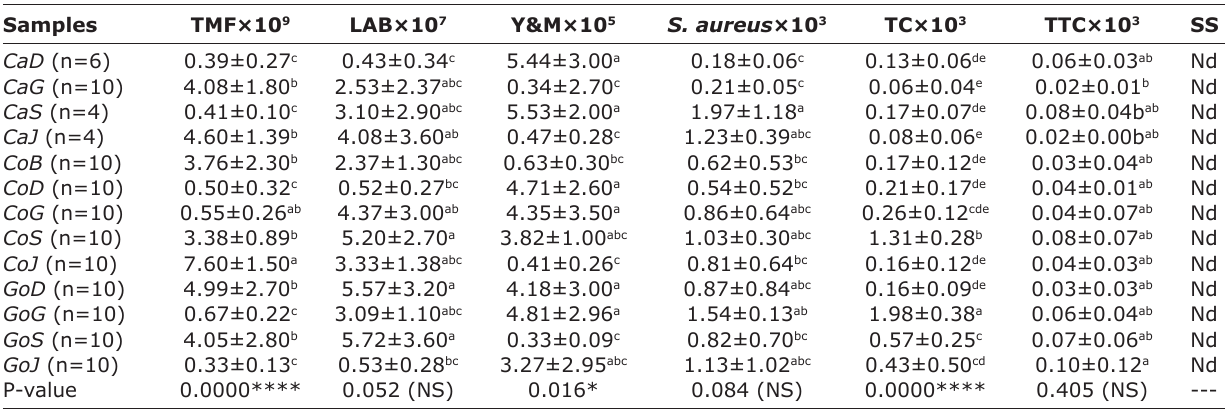
Table-3: Microbiological parameters of different fermented milk samples.